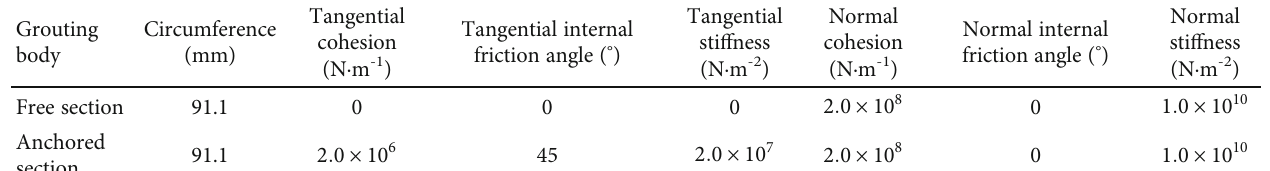
Table 4: Geometrical and mechanical parameters of the grouting body.